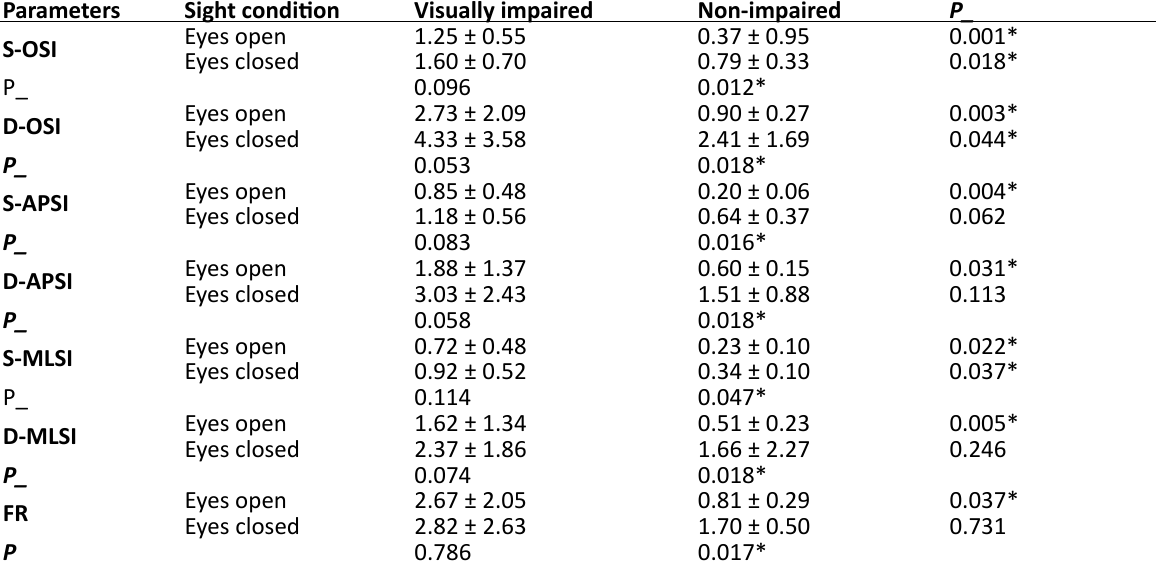
Table 2. The static and dynamic OSI, APSI, MLSI, and FR values and their inter- and intra-group mean differences of visually impaired and non-impaired Judo athletes during with the eyes open and closed